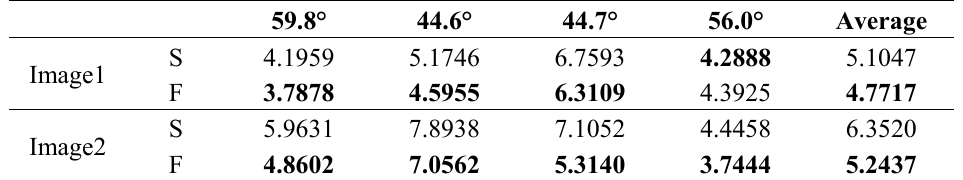
Table 1. Registration evaluation for the experimental images in terms of standard deviation in the simulation image data